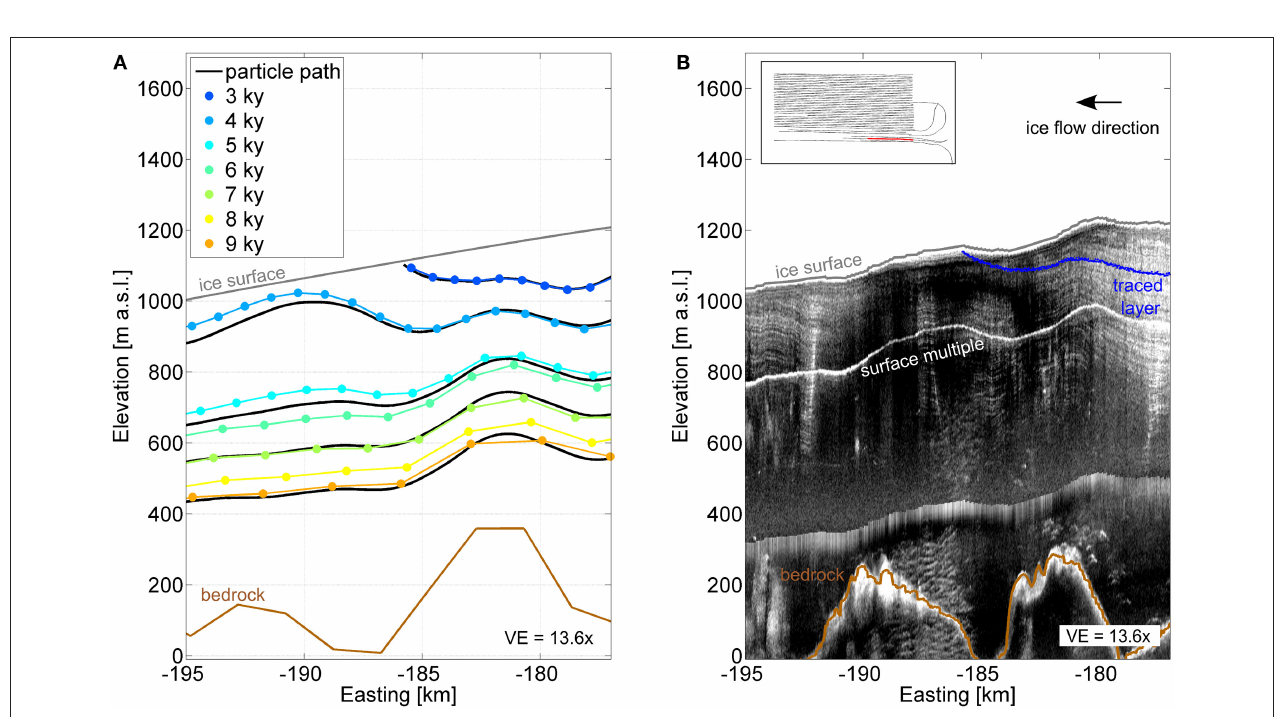
FIGURE 7 | Comparison between simulation and observation. (A) Simulated isochrones (colored lines: blue to orange, youngest to oldest) and englacial particle paths (black lines), and (B) observed internal layers in IceBridge radiostratigraphy (Leuschen, 2011), with one traced radar layer shown (blue line). The ice surface (gray line), bed (brown line), and surface multiple are as in Figure 6 . Inset shows map view of IceBridge flight lines, with the extent of this radargram segment highlighted (red).